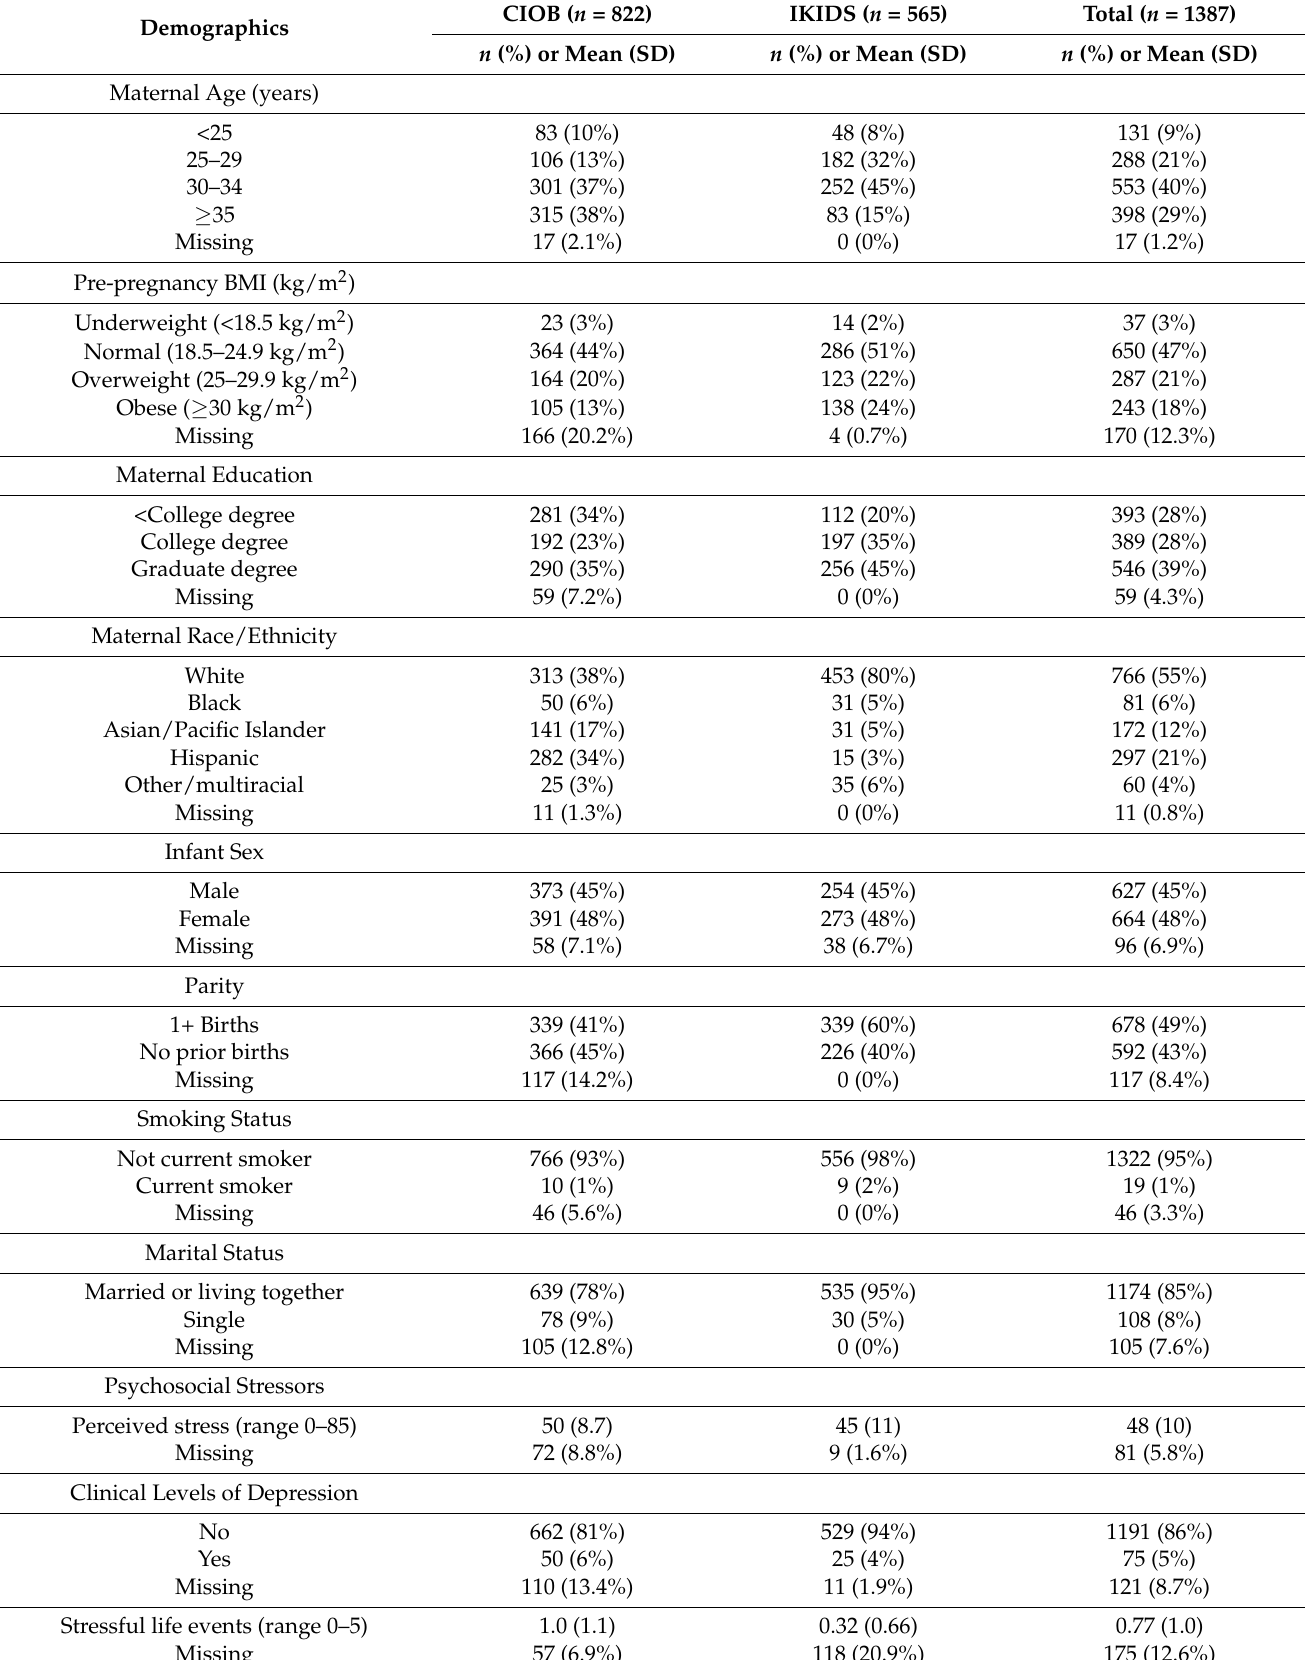
Table 1. Distribution of demographic characteristics and psychosocial stressors in environmental influences on child health outcomes (ECHO).CA.IL